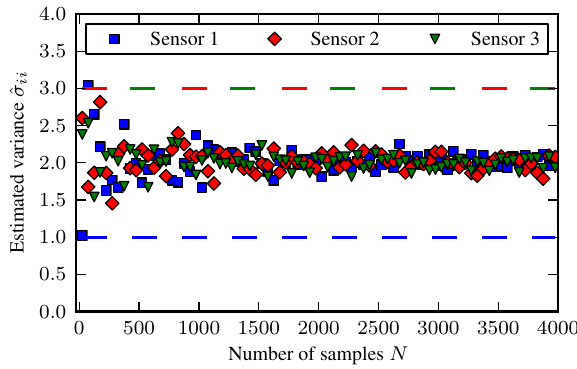
Fig. 6. Estimated variances ˆ σ 11 , ˆ σ 22 and covariance ˆ σ 12 when σ 12 is the only non-zero covariance. The solid lines indicate the ± 2SE range (around the actual value), as determined from Eq. (14) and (27).